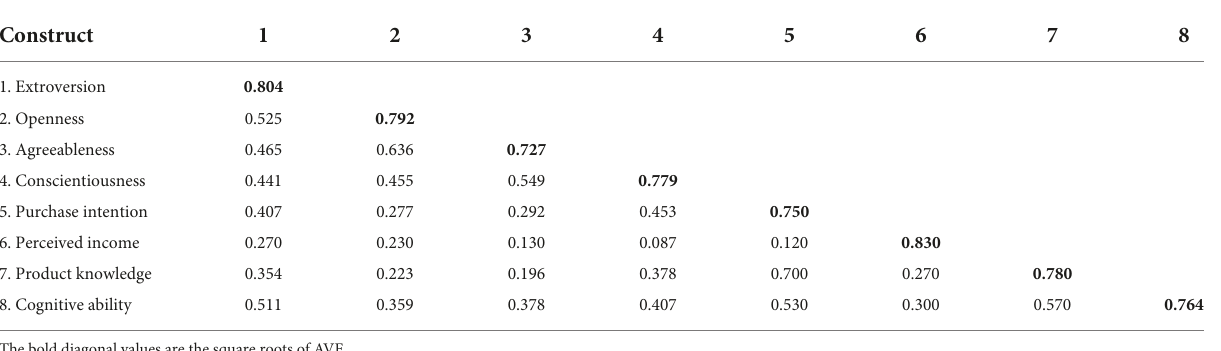
TABLE 3 Square root of AVE and correlations.